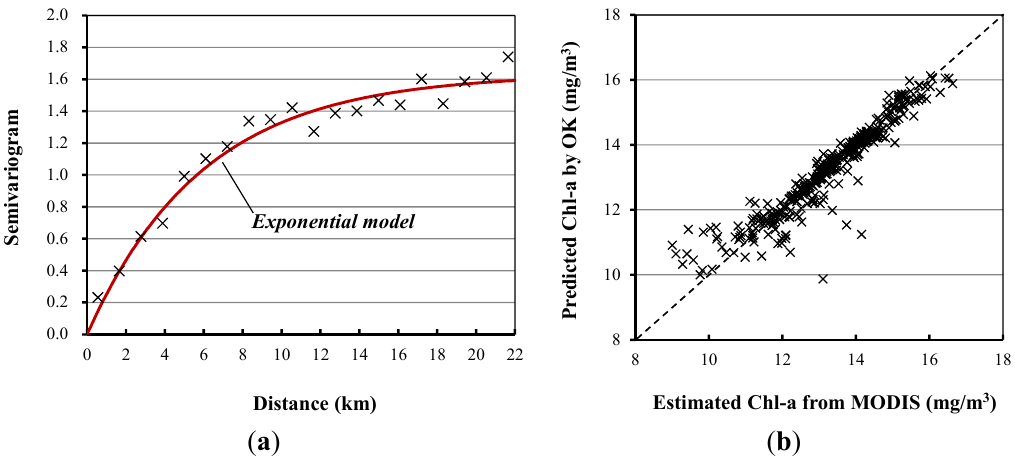
Figure 6. ( a ) Omnidirectional experimental semivariogram and exponential model (curve) of the Chl-a concentrations estimated from MODIS data and rGBr. ( b ) Scattergram for cross-validation of ordinary kriging prediction. The 45-degree dotted line is superimposed.